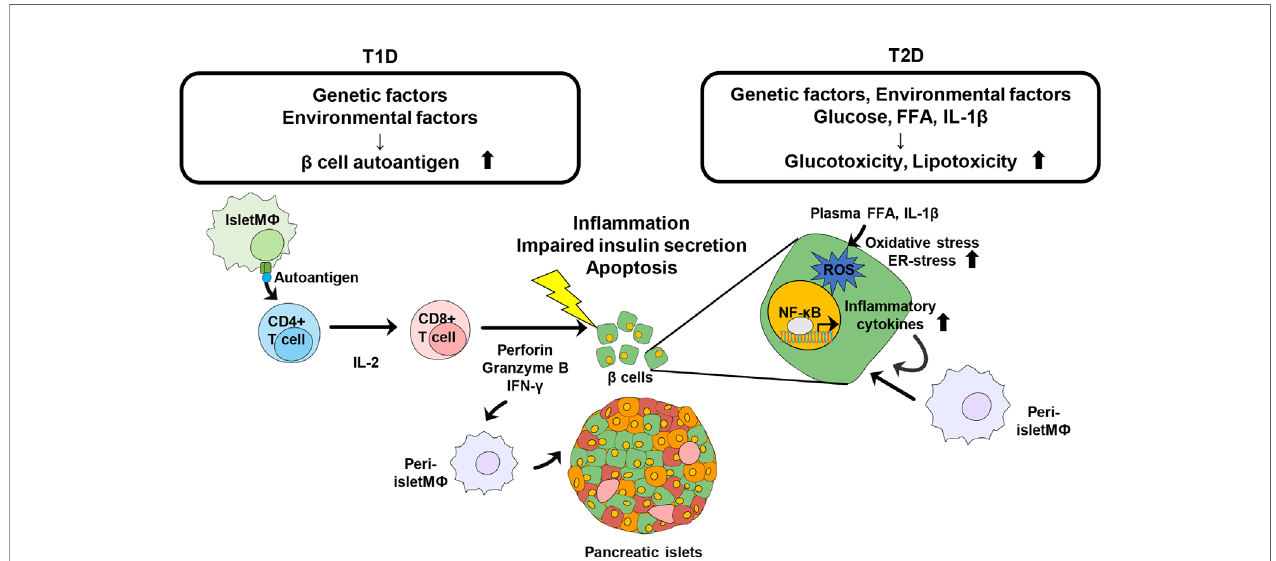
FIGURE 1 | Schematic view of Immune modulation contributing to the destruction of pancreatic b cells in diabetes. Genetic and environmental factors contribute to generation of islet autoantigens. Intra islet macrophage or DC recognize the autoantigen and present it to naïve CD4+ T cells. Activated CD4+ T cells further activate CD8+ T cells to directly damage b cells and further induce the in fi ltration of other immune cells, leading to progression of T1D. Obesity is a risk factor of pathogenesis of T2D. Increased glucose, plasma FFA, and IL-1 b promote oxidative stress and ER-stress in pancreatic b cells to induce insulin resistance as well as b cell destruction. In fl ammatory cytokines recruit other immune cells into pancreatic islets and b cells and trigger further in fl